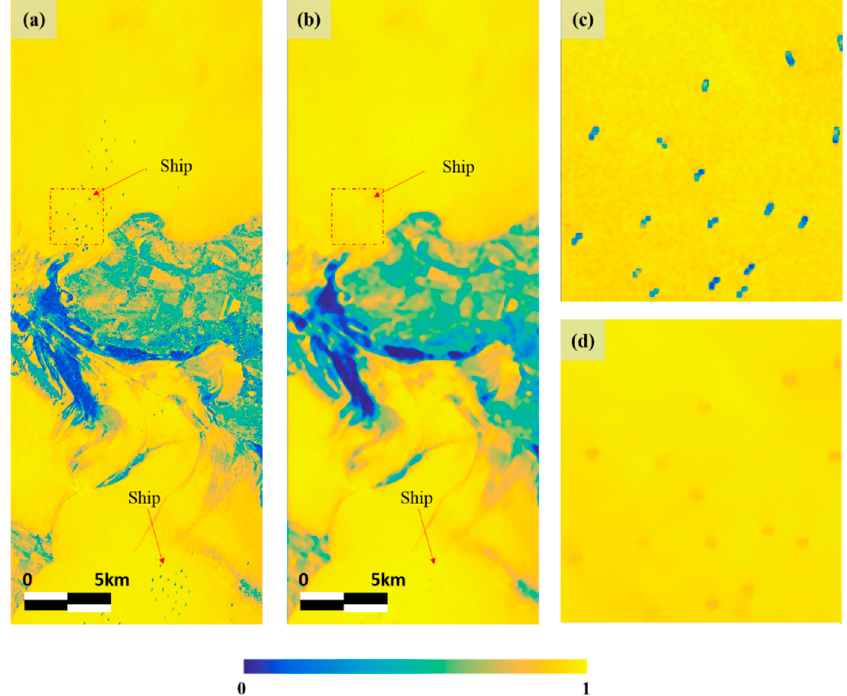
Figure 6. Coherence map before and after ship removal. ( a ) Coherence map before ship removal; ( b ) Coherence map after ship removal; ( c ) Magnified coherence map of ship area before ship removal; ( d ) Magnified coherence map of ship area after ship removal.